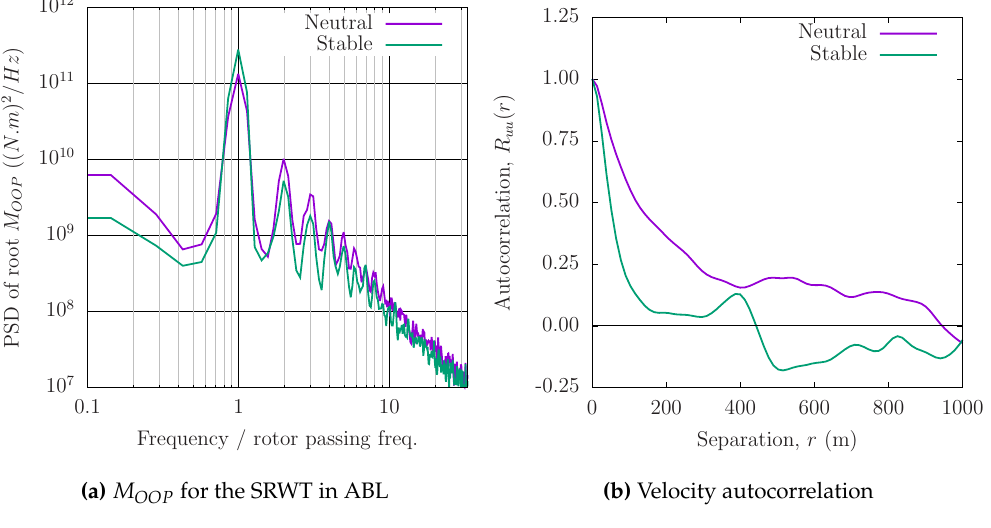
Figure 18. Autocorrelation of the velocity fluctuation as a function of